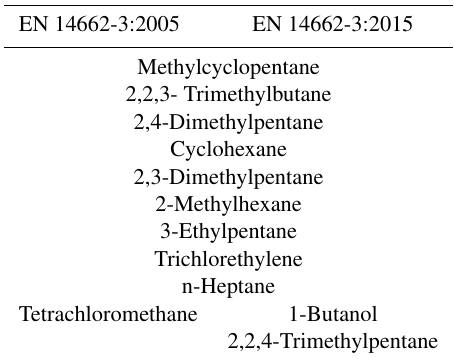
Table 1. Organic compounds used to assess interferences in the measurement of benzene in the air, in accordance with standards EN 14662-3 (2005 and 2015